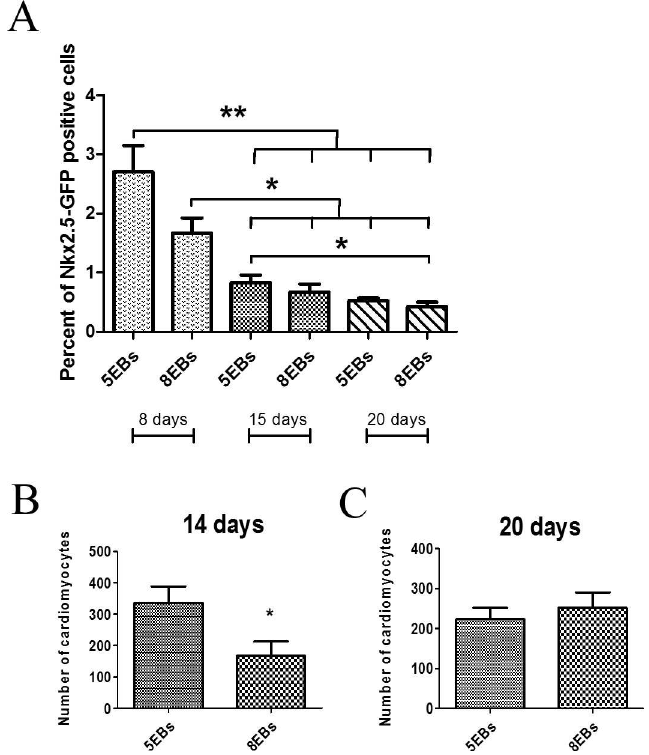
Fig 3. Flow-cytometric analysis of the Nkx2.5-GFP positive cell ratio in cultures derived from 5- and 8-day-old EBs. Samples were analyzedon days 8, 15 and 20 of differentiation (A). Number of cardiomyo- cytes formed per one EB (400 cells per EB were seeded)on days 15 and 20 of differentiation (B, C). Data are expressedas mean ± SEM (n = 4). Differences betweensamples were analyzedby ANOVA with Bonferroni’s MultipleComparisonTest (A) and paired T-test (B, C) and considered statistically significantfor p (cid:20) 0.05; they are marked with asterisks.